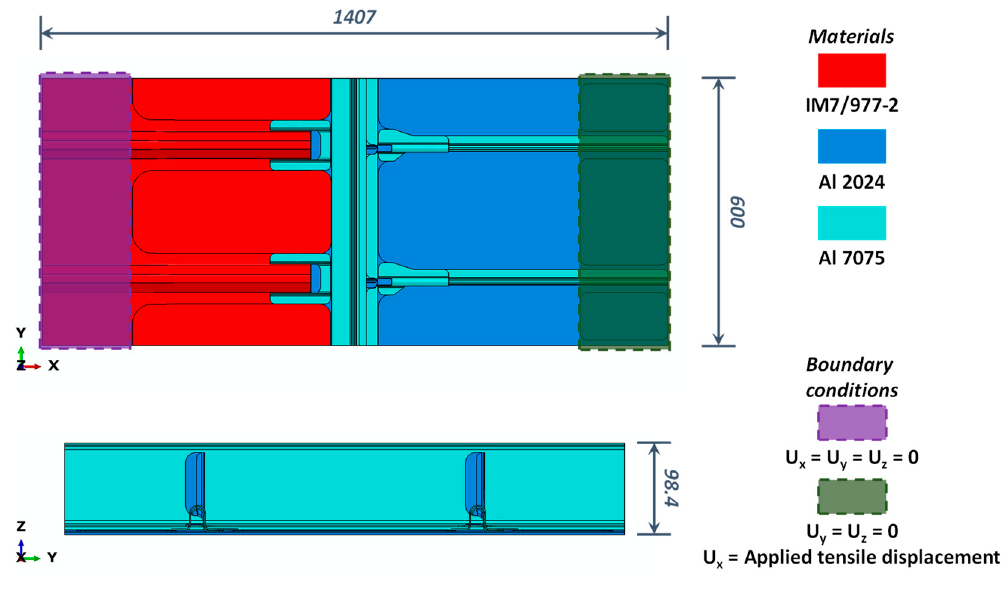
Figure 1. Geometrical description, materials, and boundary conditions of the investigated structure (dimensions in mm).